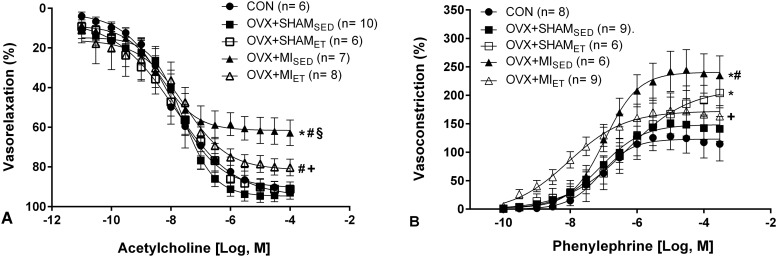
Concentration-response curves to acetylcholine (A) and phenylephrine (B) in isolated aortic rings of Wistar rats.Data are expressed as mean ± standard error of the mean (SEM). Two-way ANOVA followed by the Fisher post-hoc test for multiple comparisons. *p <0.05 vs control; #p <0.05 vs OVX+SHAMSED;. §p <0.05 vs OVX+SHAMET; +p <0.05 vs OVX+MISED.